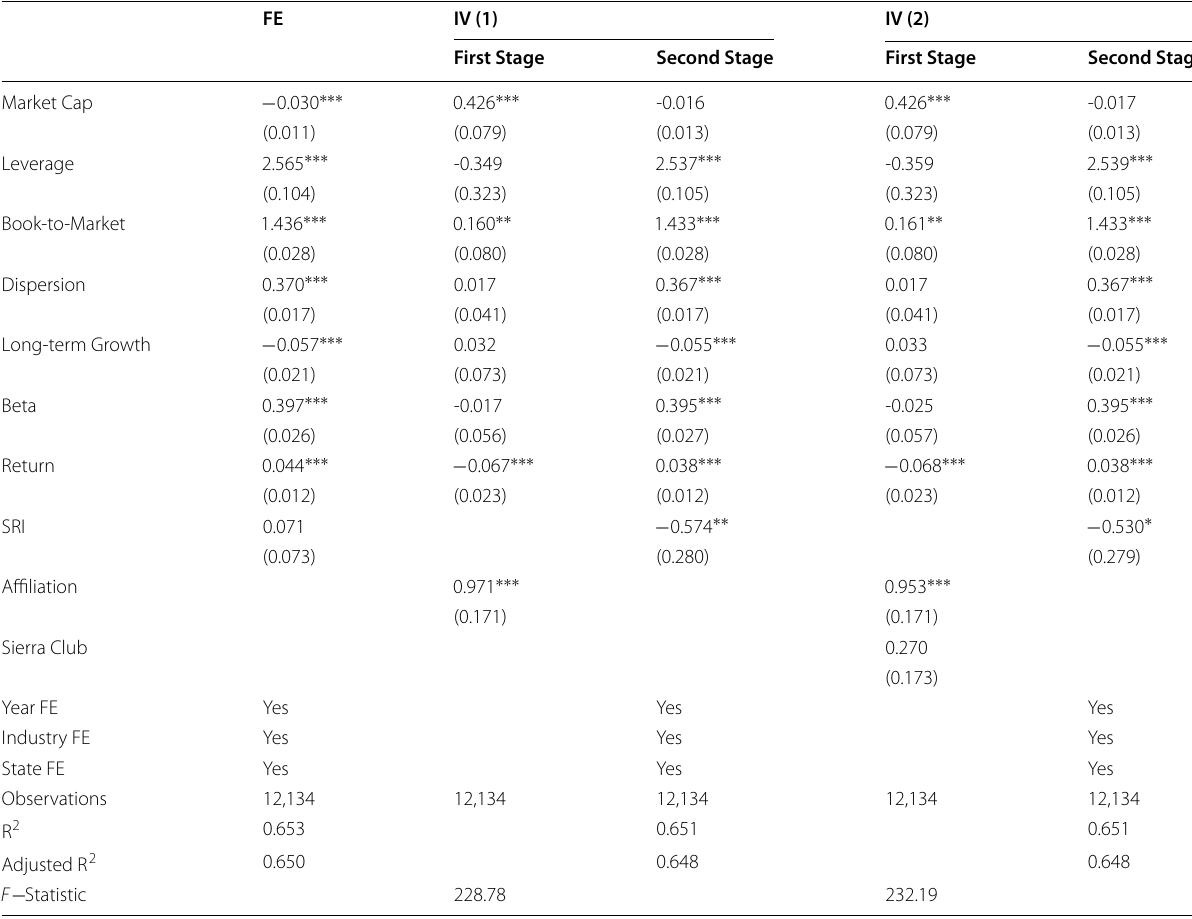
Table 3 Results of baseline and IV